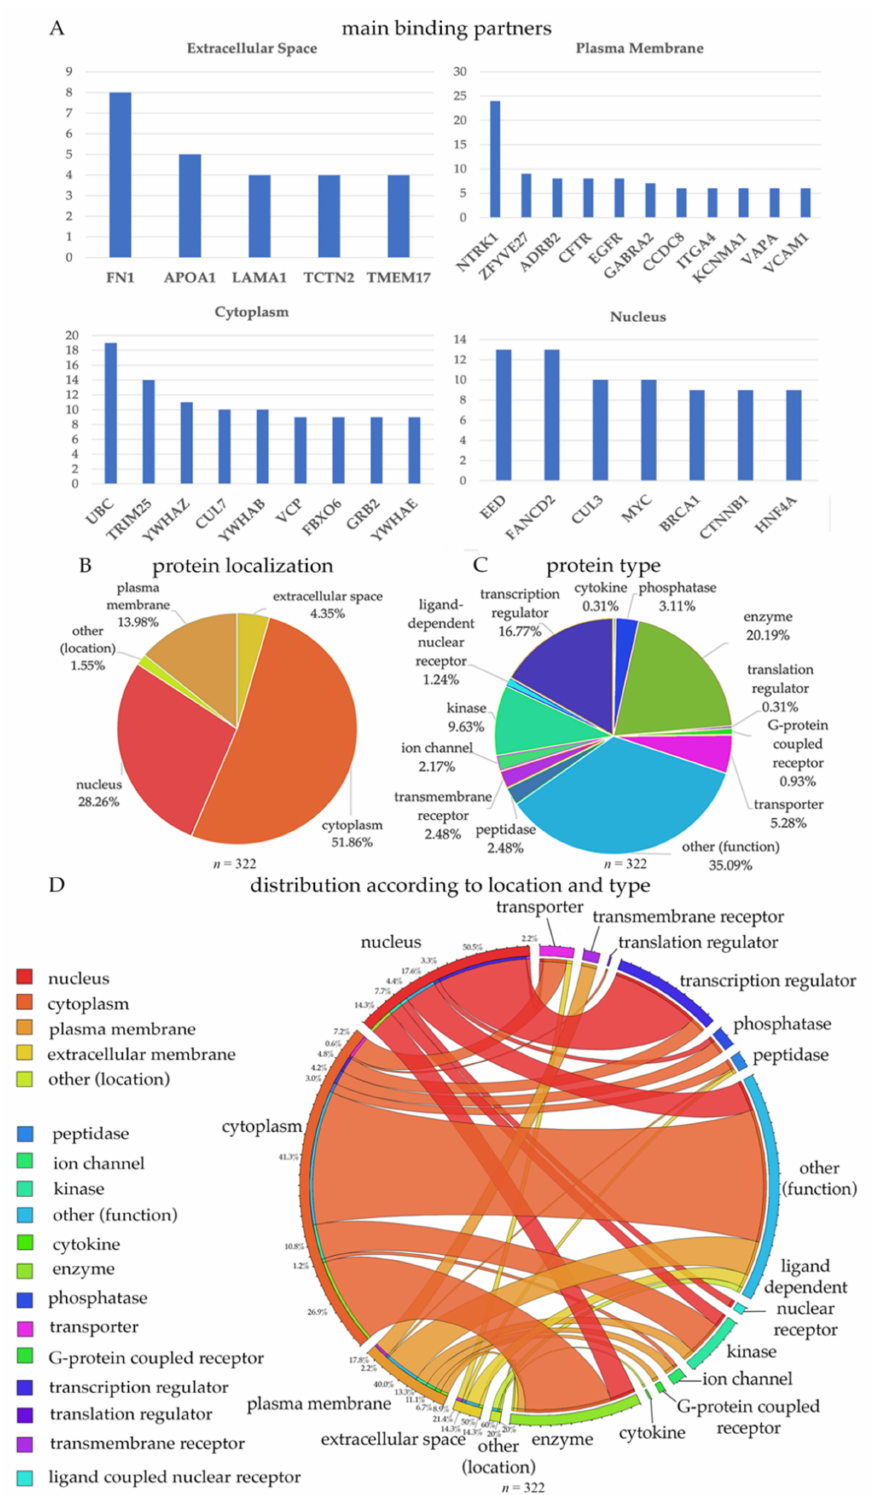
Figure 1. Binding partners of proteins coded by the mutated genes detected in HSP and PLS patients. ( A ) Bar graph representation of proteins with the highest number of bindings partners, located in the extracellular matrix, plasma membrane, cytoplasm and nucleus. Percent distribution of proteins based on location ( B ) and function ( C ). ( D ) Circle representation of proteins based on location and